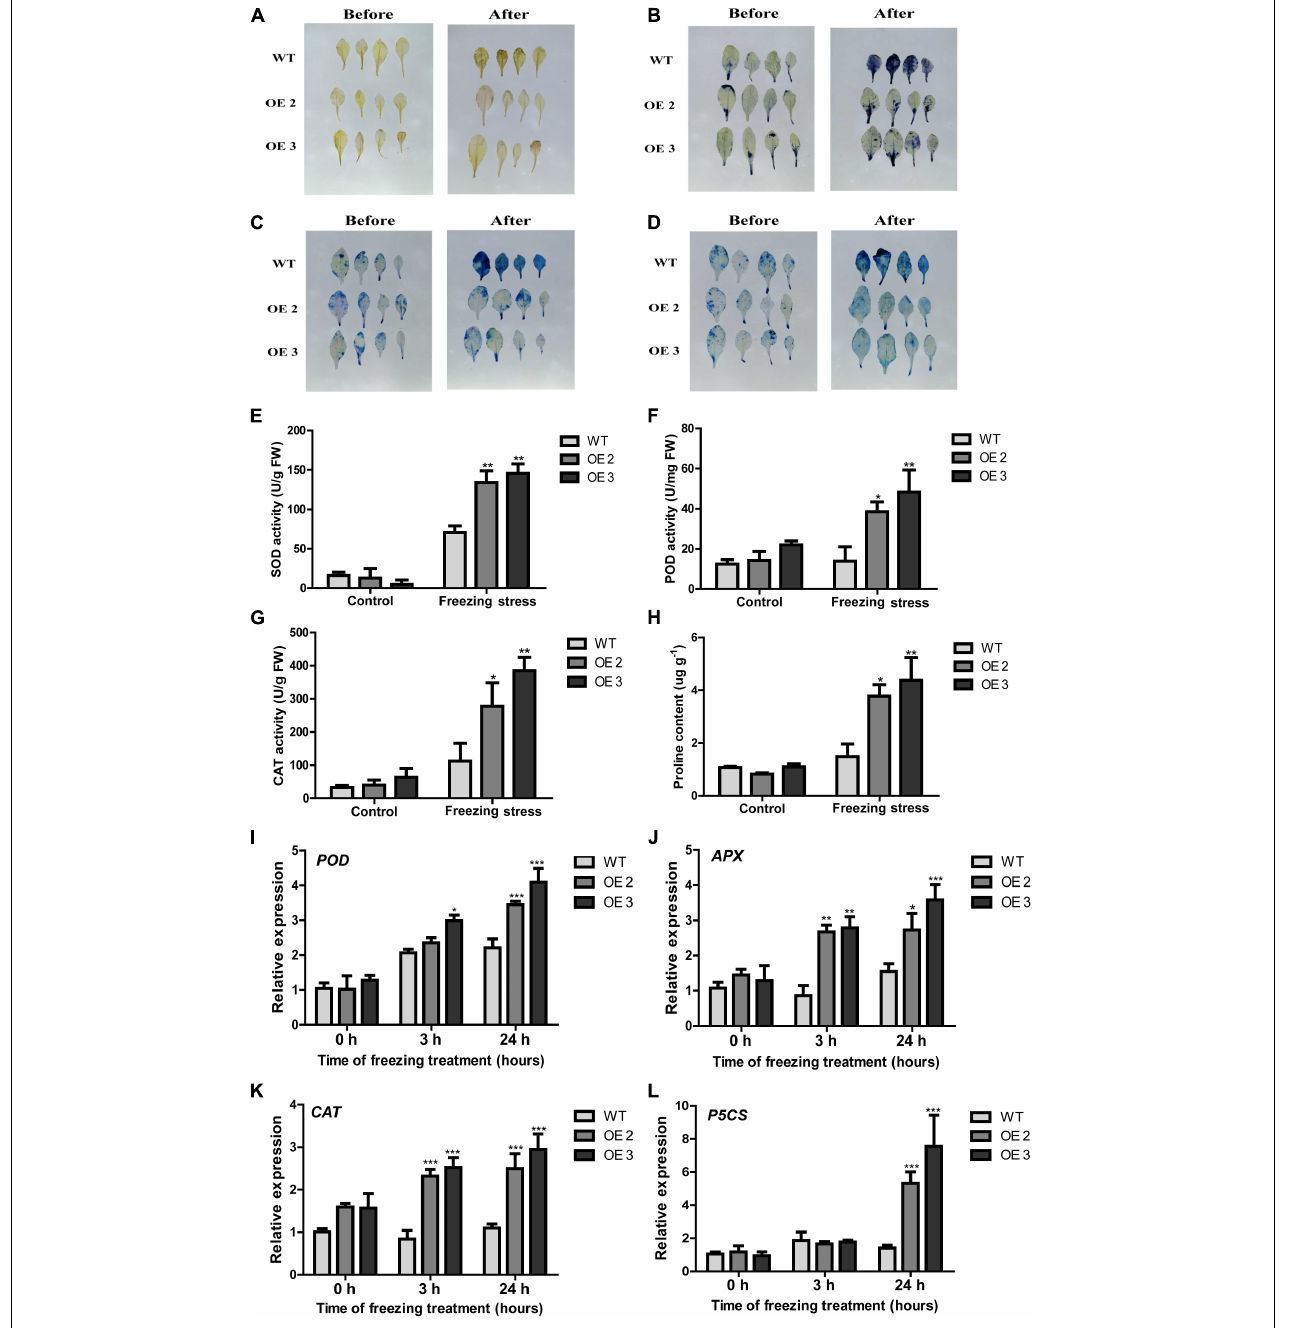
FIGURE 5 | The performance of HcTOE3 transgenic Arabidopsis under freezing treatment. (A) H 2 O 2 detection in plant leaves by DAB staining. (B) O 2 - detection in plant leaves by NBT staining. (C , D) Dead cell detection in plant leaves by Evans blue and trypan blue staining. (E) SOD activity. (F) POD activity. (G) CAT activity. (H) Proline content. (I–K) Expression levels of antioxidant enzyme genes, including POD , APX , and CAT . (L) Expression level of osmotic regulation gene P5CS . Data represented the average of three biological replicates. Significant differences at * p < 0.05, ** p < 0.01, and *** p <